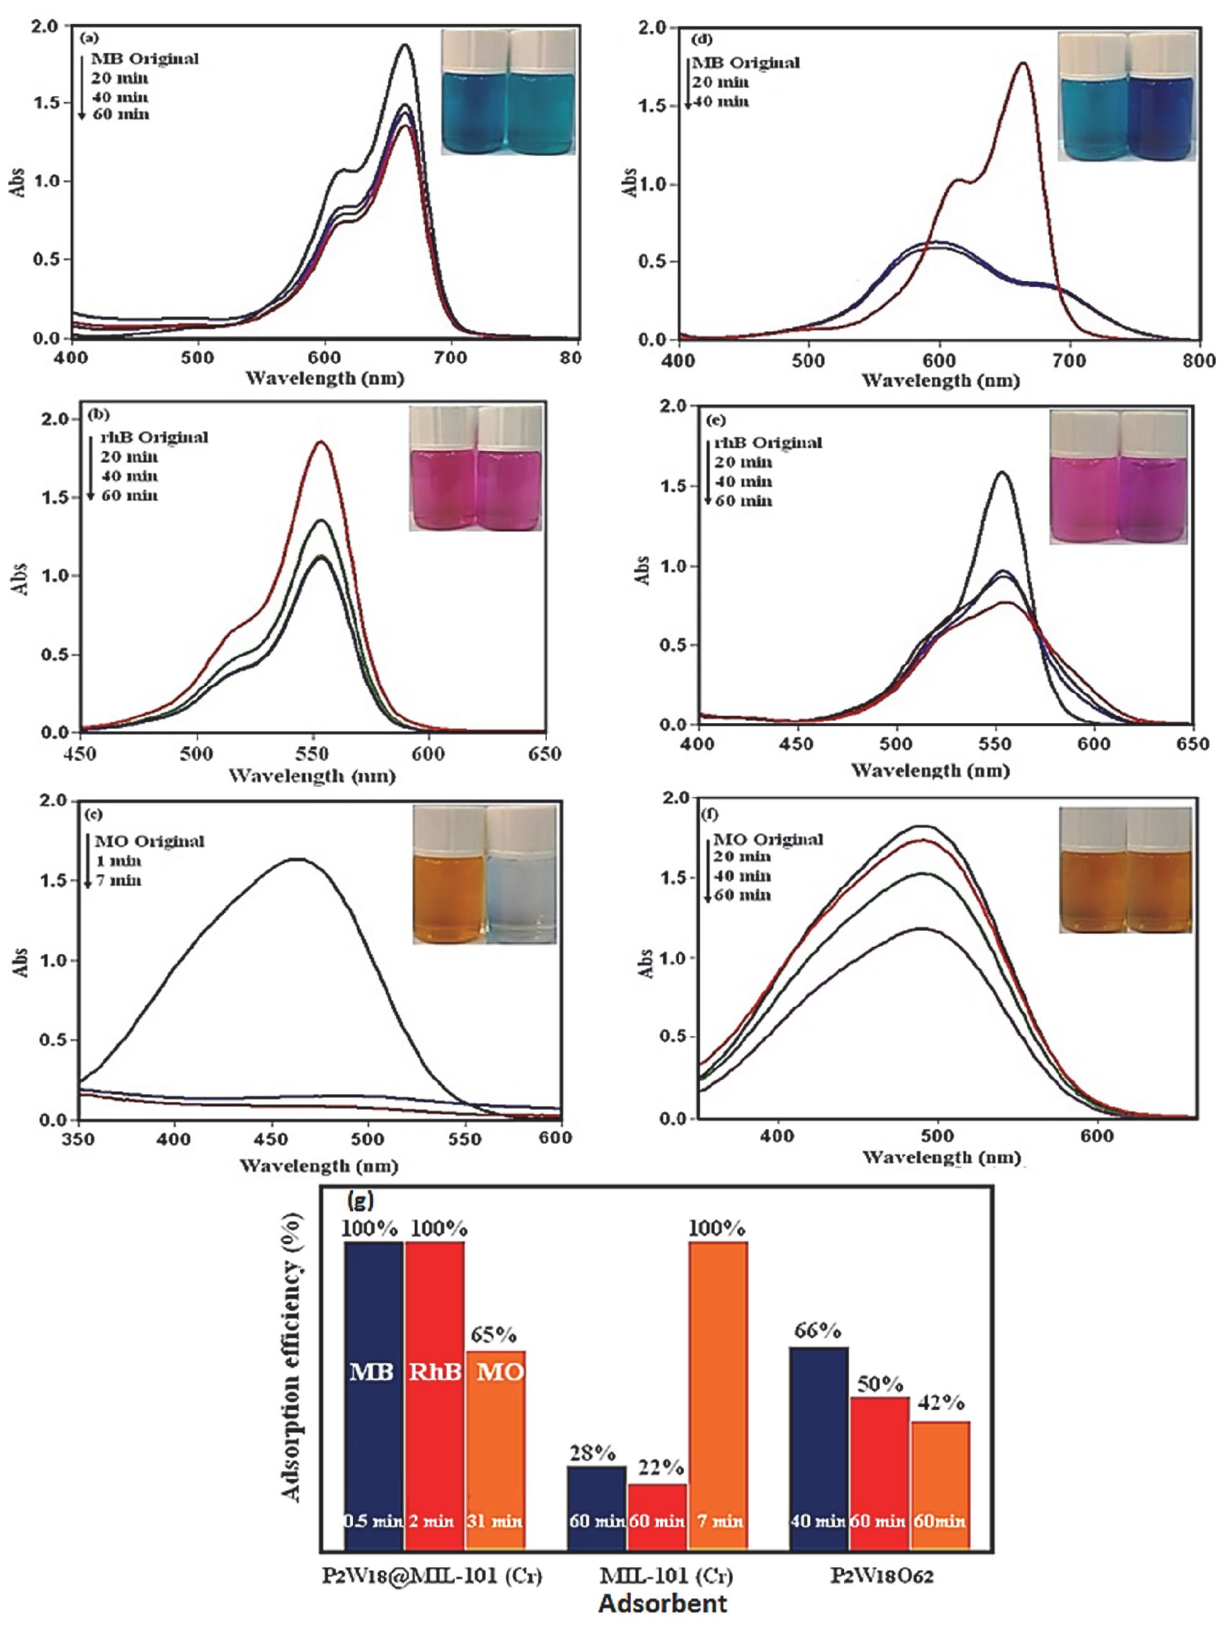
Figure 9. The adsorption capabilities of (a)-(c) pristine MIL-101(Cr) and (d)-(f) pure P 2 W 18 toward MB, RhB, and MO dyes. (g) Adsorption effi- ciency (%) of the dyes in the presence of different adsorbent